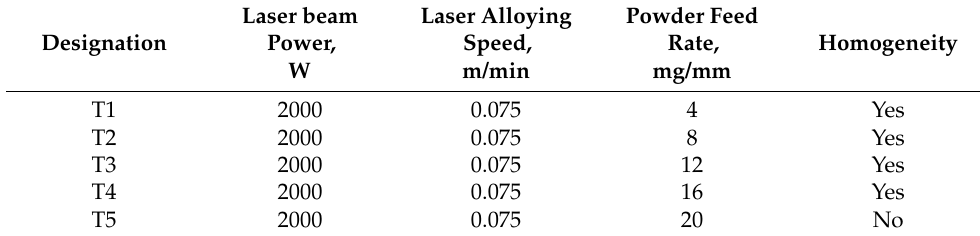
Table 3. Laser surface alloying process